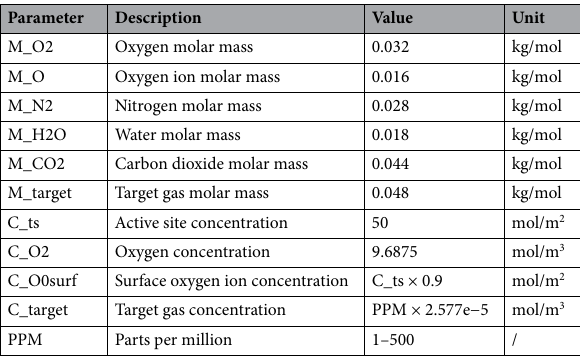
Table 1. Sensing principle parameters.